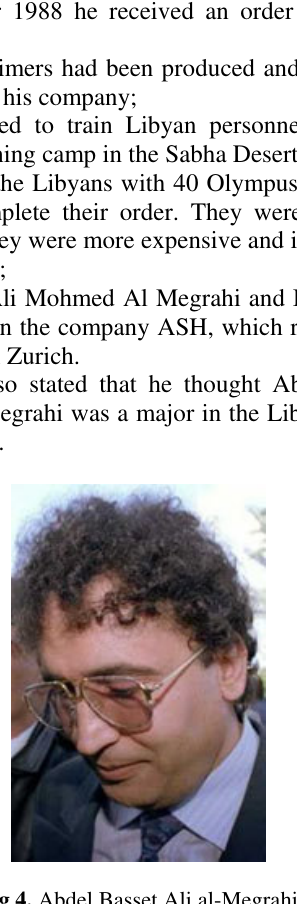
Fig 4. Abdel Basset Ali al-Megrahi From further investigation and intelligence